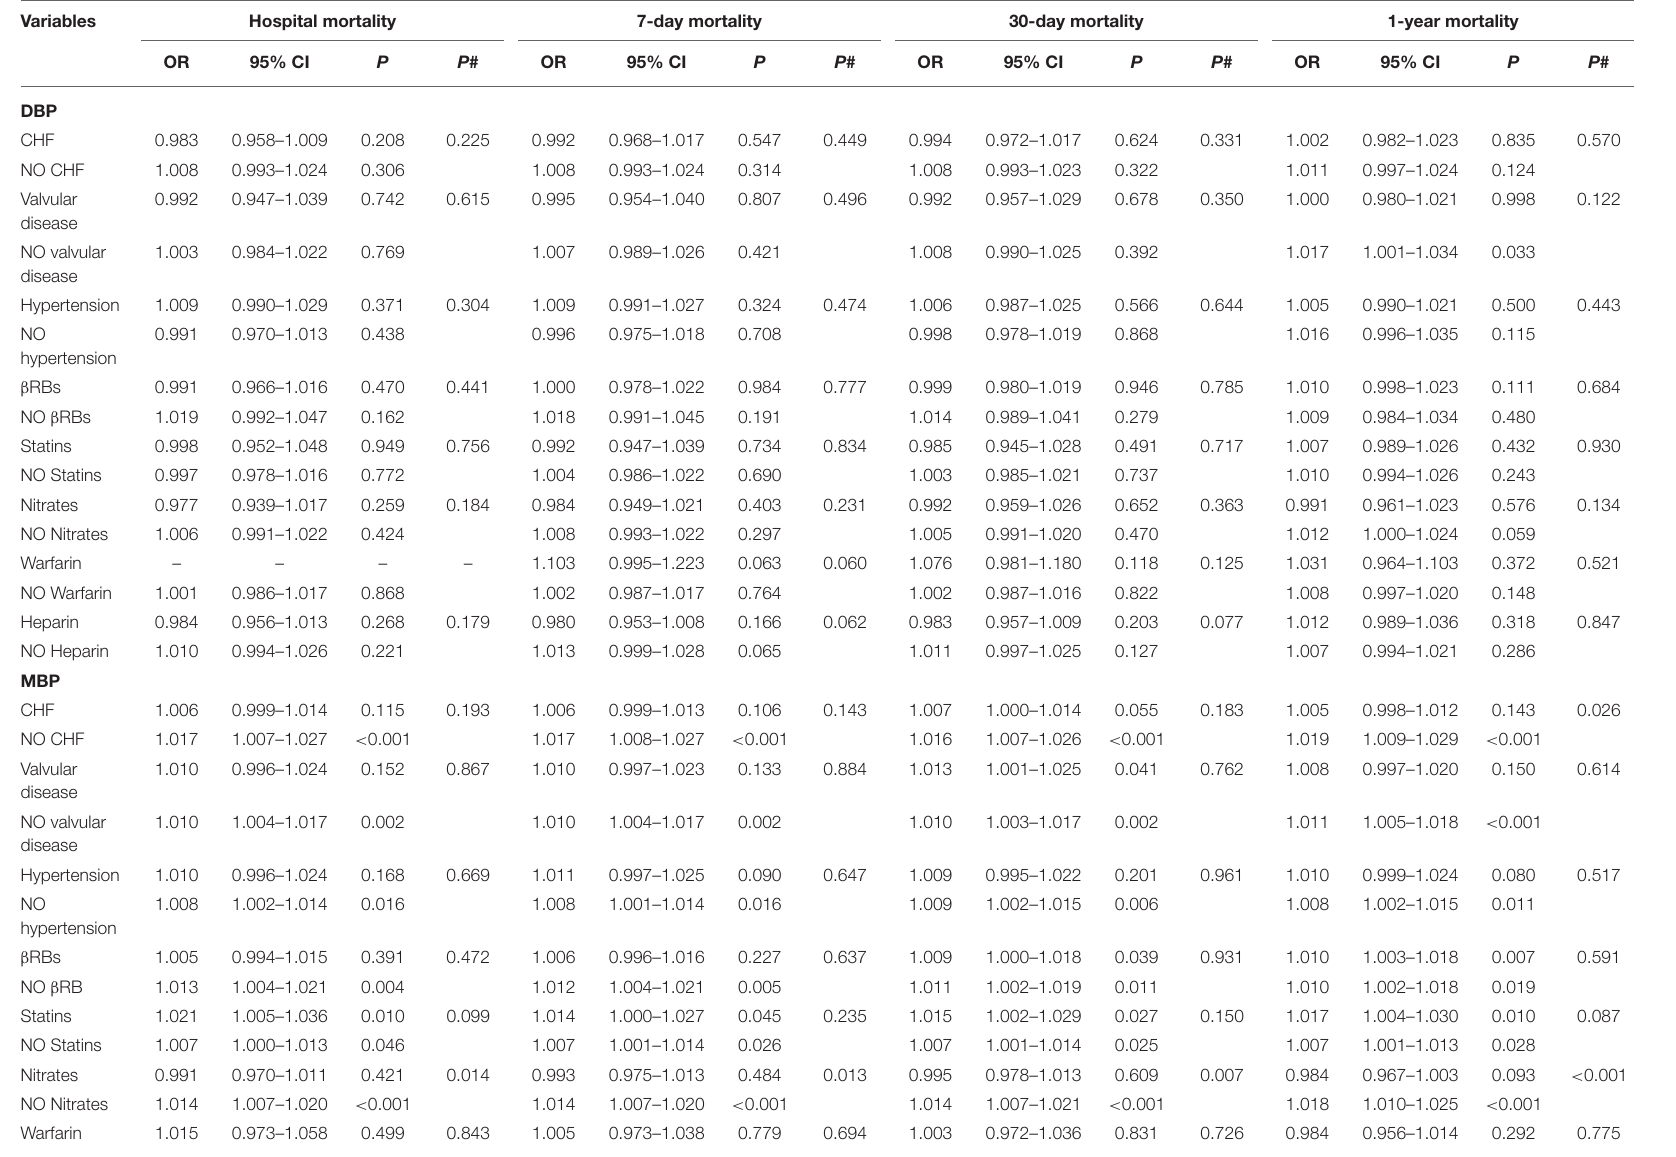
TABLE 5 | Multiple logistic regression analysis for relationship between BP ( > 55/70/110 mmHg) and mortality by stratified